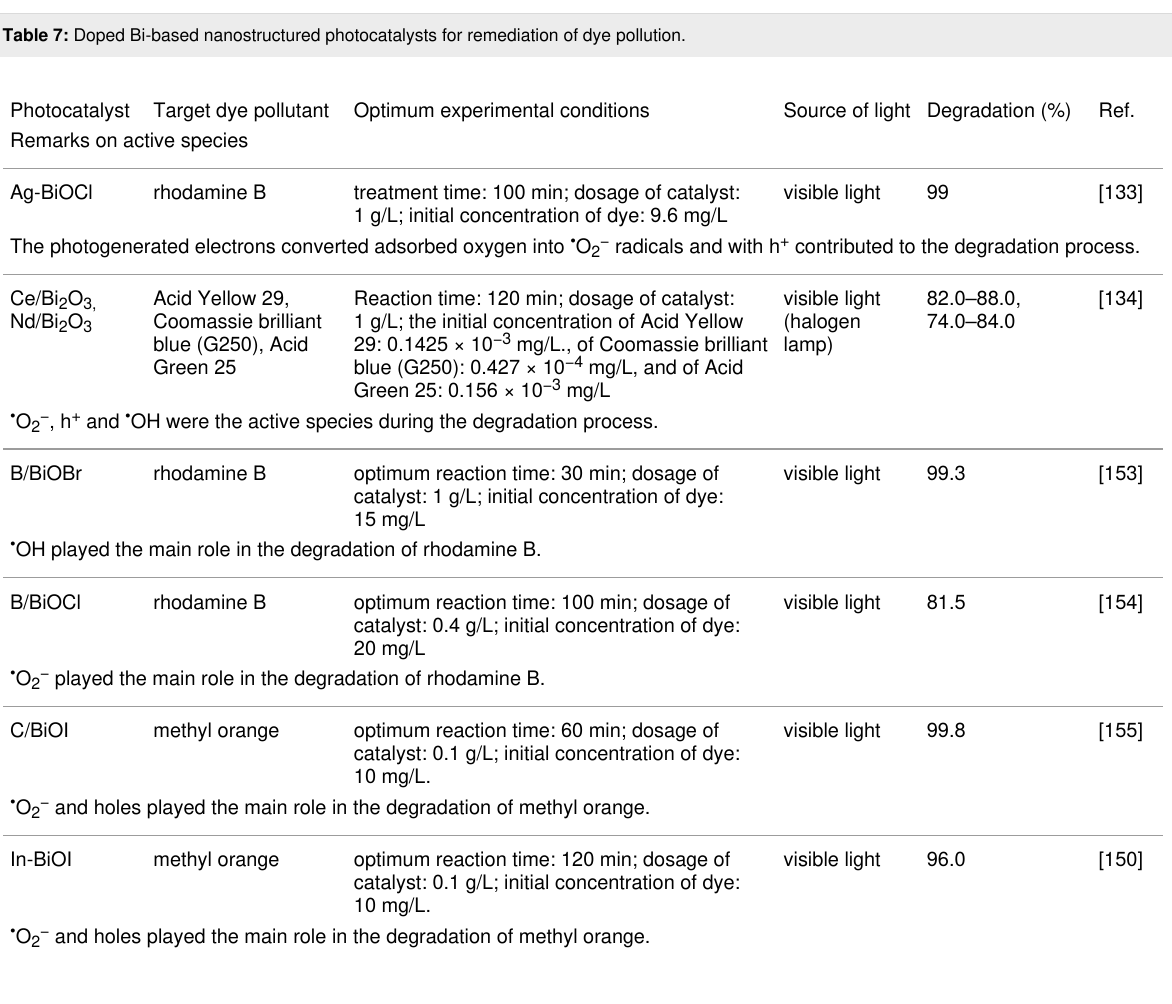
Photocatalyst Target dye pollutant Optimum experimental